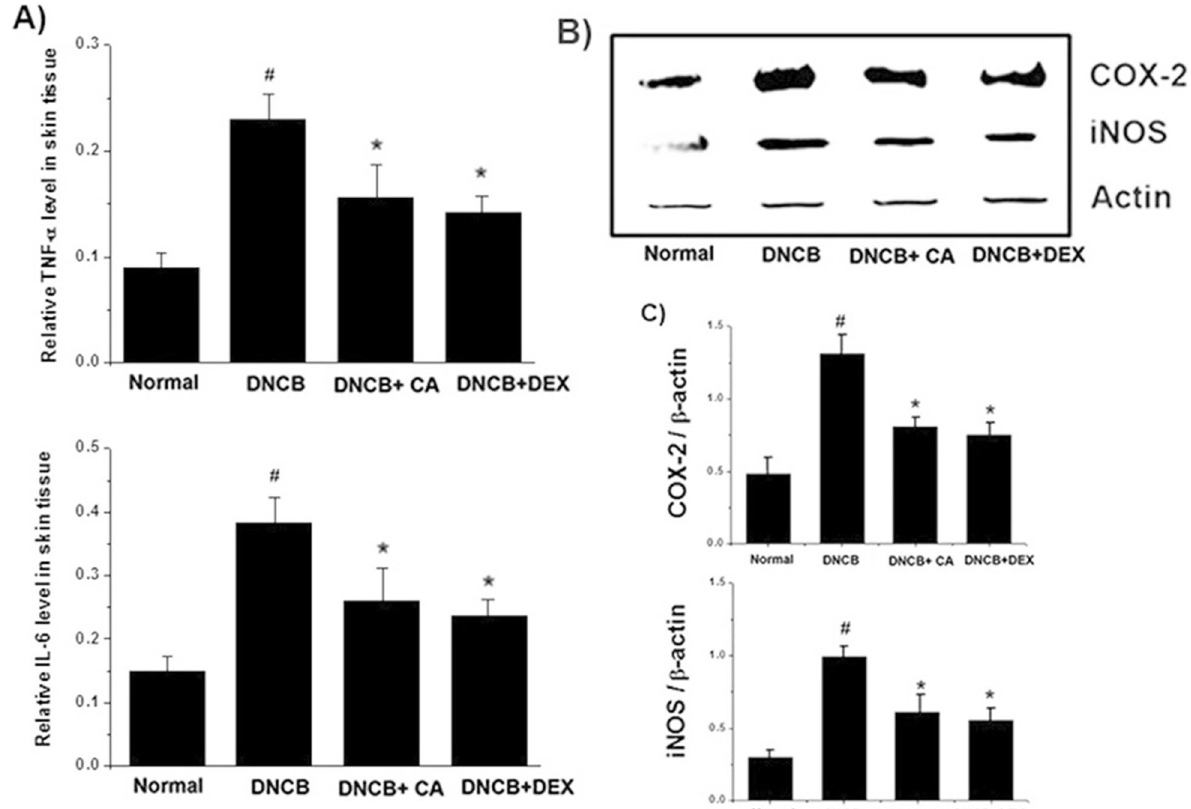
Fig. 4 Effect of CA on skin inflammation‑related gene levels in AD‑like skin lesion. A At the end of experiment, the skin tissues were cut out and homogenized. The level of TNF‑α and IL‑6 in the indicated groups was measured via ELISA. B The levels of COX‑2 and iNOS in the indicated groups were determined by Western blot analysis. C The relative COX‑2 and iNOS levels were determined by densitometry. The data represents the mean S.D. of three independent experiments ( # p < 0.05 vs. control group, * p < 0.05 vs. DNCB‑treated ±